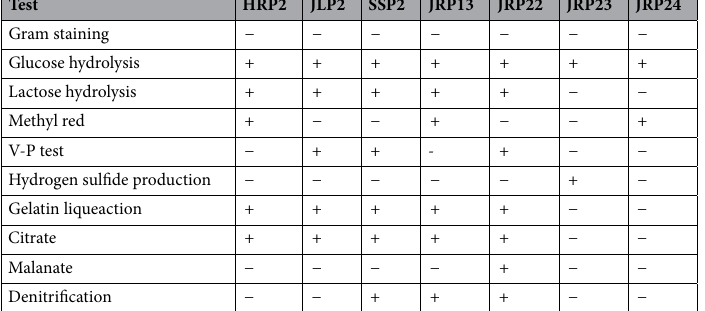
Table 3. Physiological and biochemical features of phosphate-solubilizing bacteria.